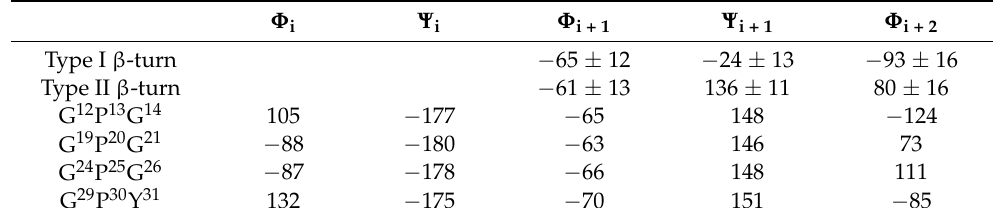
Table 2. Dihedral angle of the (i + 1) and (i + 2) residues of the four Pro-Gly motifs in the repetitive 32-residue sequence calculated by TALOS-N together with typical dihedral angle of type I β -turn and type II β -turn.